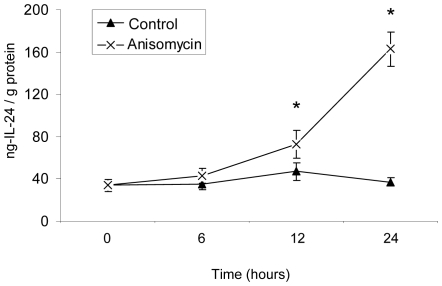
IL-24 protein expression in the supernatant of NHEK treated with medium control or anisomycin (300 ng/ml).NHEK were cultured in the presence or absence of anisomycin for up to 24 hours. IL-24 protein levels in the supernatant were analyzed by ELISA. IL-24 protein concentrations were normalized to the calculated total protein concentration of the whole cell extracts.*p<0.05 compared with cells harvested before stimulation (0 hours) (n = 5 cultures). Points indicate mean ± SEM.